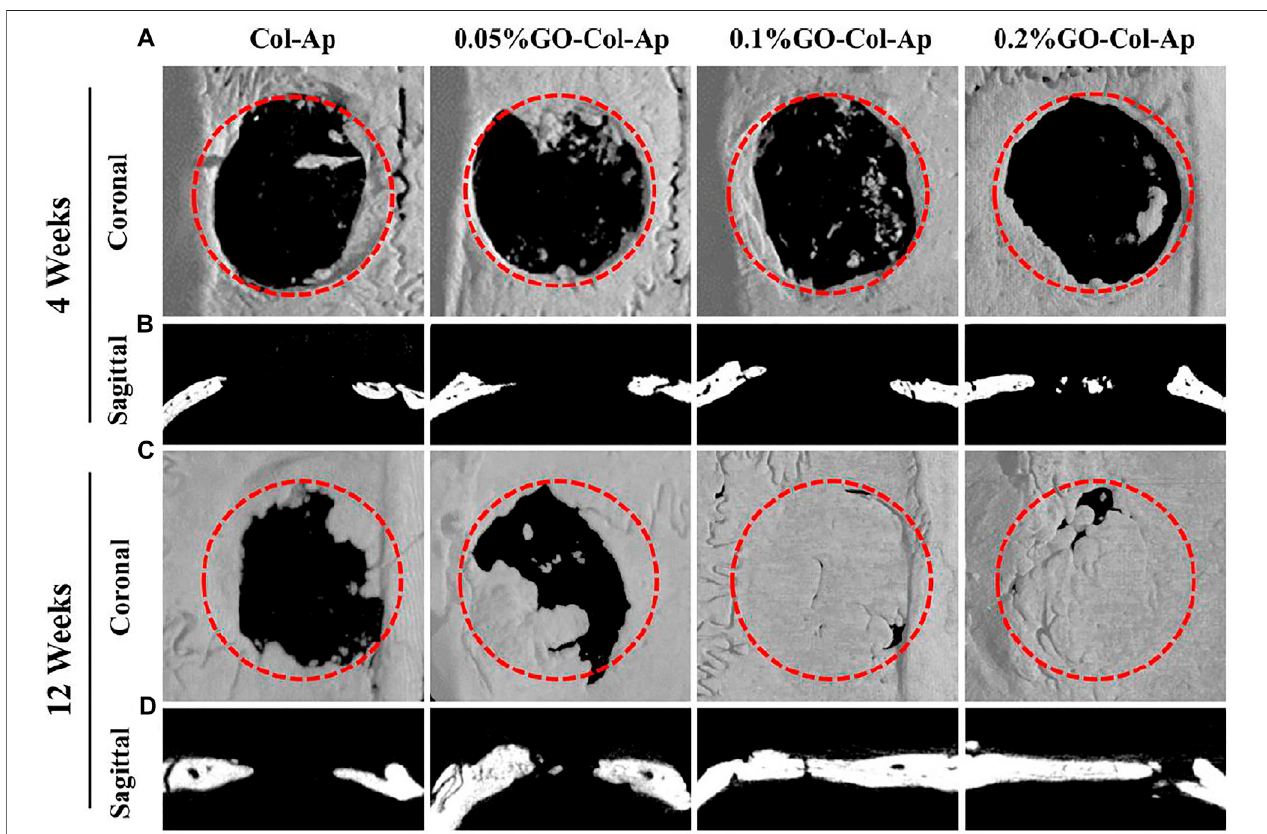
FIGURE 2 | In vivo evaluation of the scaffolds using the critical-sized defect (A, C) Three-dimensional reconstruction and (B, D) coronal section analysis of the defectareasat4and12 weeks (A,B) Newbonewasformedinthefourgroupsat4 weeks,and (C,D) almostcompletehealingofthebonedefectswasobservedin0.1 and0.2%GO − Col − Apgroupsat12 weeks.Dottedredcircle:defectarea.ReproducedfromZhouetal.(2018)withpermissionfromCopyright2018AmericanChemical